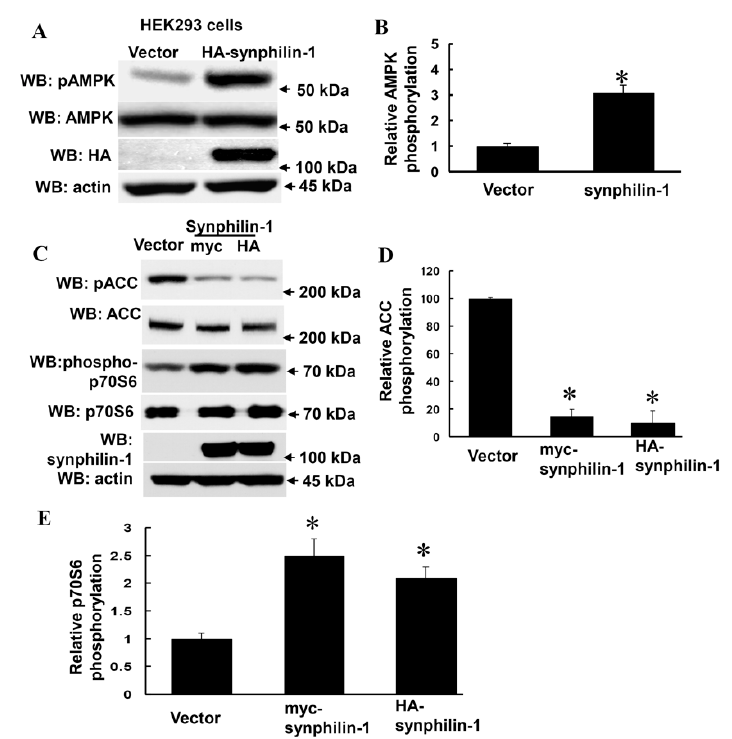
Figure 1. Overexpression of Synphilin-1 increased AMPK phosphorylation. ( A ) HEK293 cells were transfected with myc-synphilin-1 and vector for 48 h. ( A , B ) Cell lysates from HEK293 cells expressing human synphilin-1 were subjected to immunoblot analysis using anti-HA, anti-AMPK α , anti-phosphorylation AMPK α (pAMPK), and anti-actin antibodies. ( A ). Representative blots from three separated experiments. ( B ) Quantification of phosphorylated AMPK α levels normalized to total AMPK α levels. ( C – E ) Cell lysates from HEK293 cells expressing human synphilin-1 were subjected to immunoblot analysis using anti-ACC α , anti-phospho-ACC α (pACC), anti-phospho-p70S6, anti-p70S6, anti-synphilin-1, and anti-actin antibodies. ( C ) Representative blots from three separated experiments. ( D , E ). Quantification of phosphorylated ACC α and p70S6 levels normalized to total ACC α and p70S6 levels. * p < 0.05 by ANOVA followed by Tukey’s post-hoc test, vs. vector control cells.